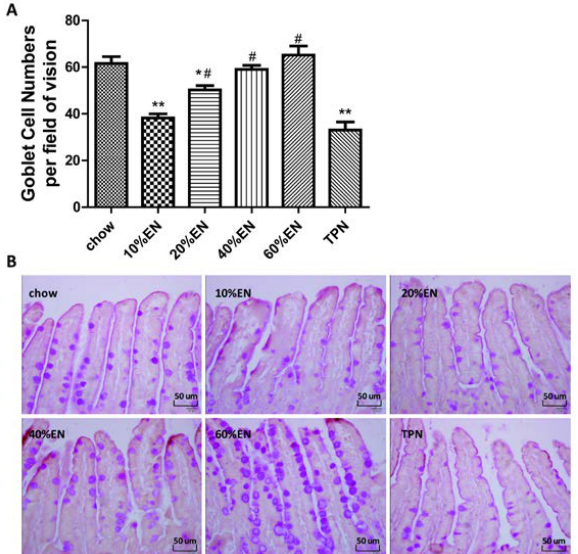
Figure 1. Morphological changes in the ileal tissue in each treatment group. ( A ) Numbers of goblet cells per field of vision; Data are presented as the mean ± standard error of the mean (SEM). ** p < 0.001 vs. chow. * p < 0.05 vs. chow. # p < 0.001 vs. TPN; ( B ) Representative images of periodic acid-Schiff (PAS) base-stained paraffin sections in each group. PAS-stained goblet cells are visible in the epithelial layer (original magnification: ×40). EN: enteral nutrition; TPN: total parenteral nutrition.